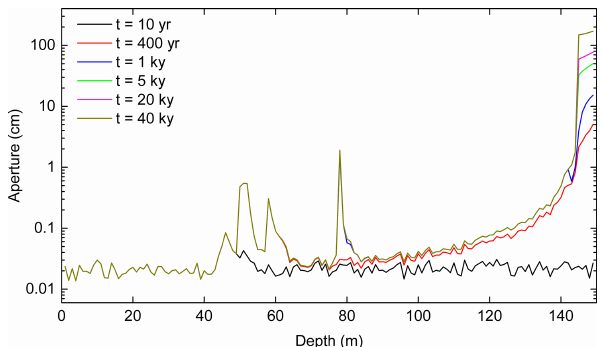
Figure 11. Aperture widths of horizontal fractures along a vertical profile at the position marked by dashed line (p) in Fig. 10a. Note that in the late evolution widening of fractures is restricted to the fractures at base